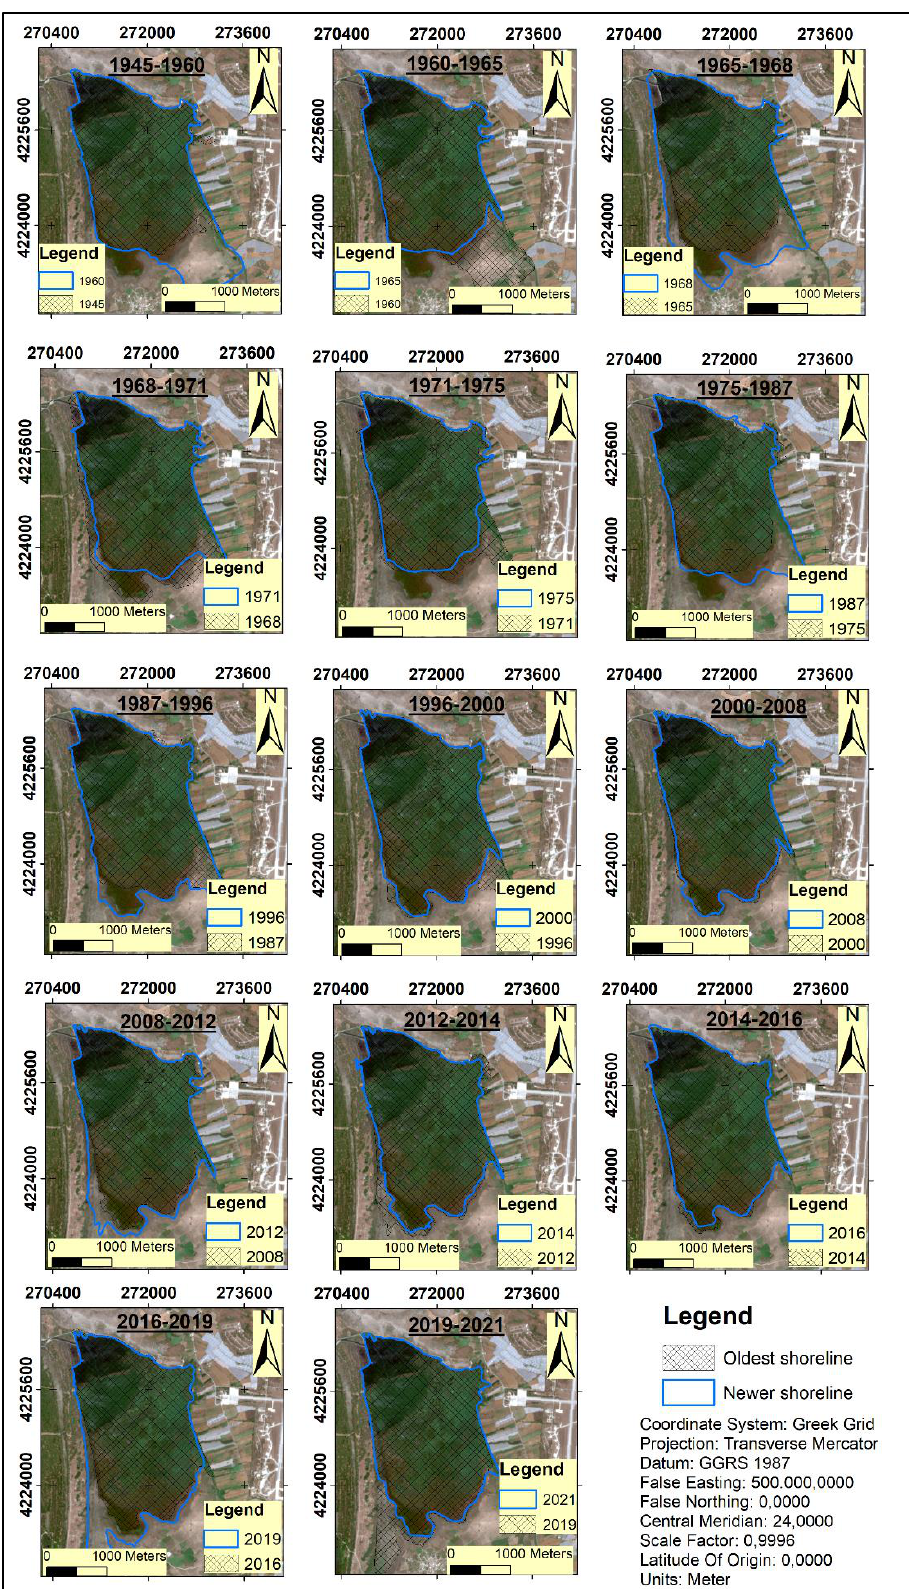
Figure 11. Multitemporal fluctuations in the Prokopos Lagoon. The gridded polygon represents the oldest surface, which is compared to the newer shoreline (blue line) at each time interval. Basemap of 2021.